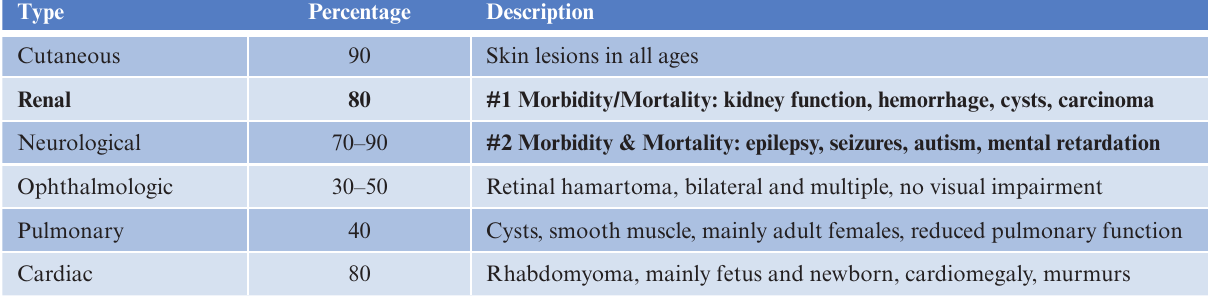
Table 1: The manifestations of tuberous sclerosis complex and the percentages of distribution.